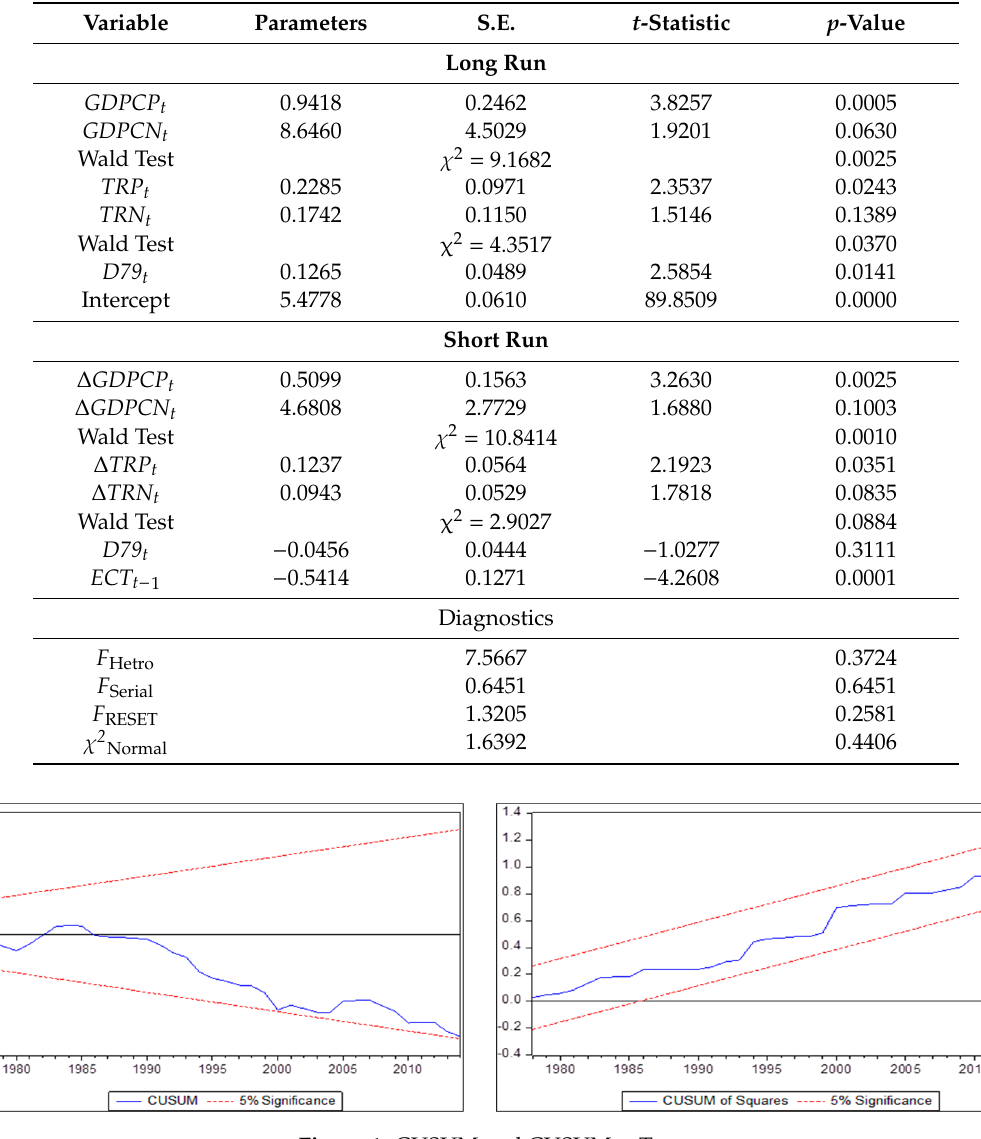
Table 3. Energy Consumption Model.